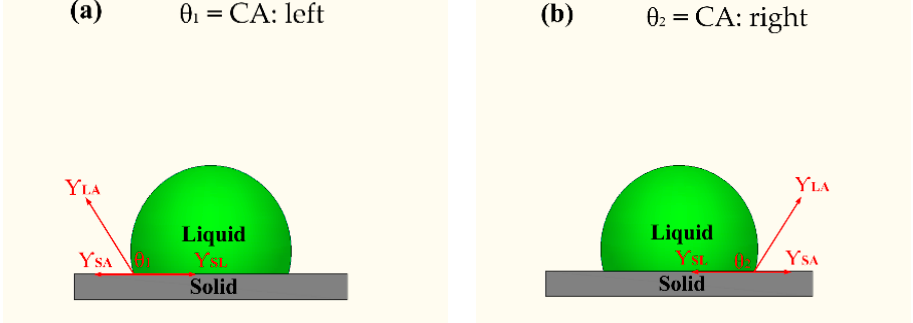
Figure 3. Schematic diagram of contact angle for an ideal smooth